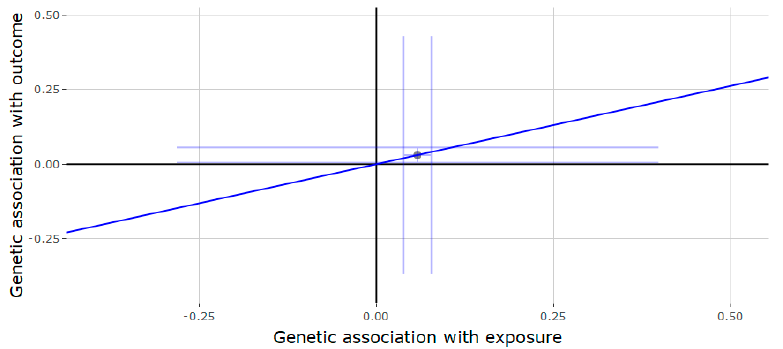
Figure 2. Genetic association of type II diabetes (T2D) against genetic association of testosterone ( JMJD1C locus). The slope (dark blue line) represents the causal association of testosterone with T2D (generated via inverse variance weighted Mendelian randomization), while the point on the plot and the lights around it (light blue lines) represent the SNP and its confidence intervals.